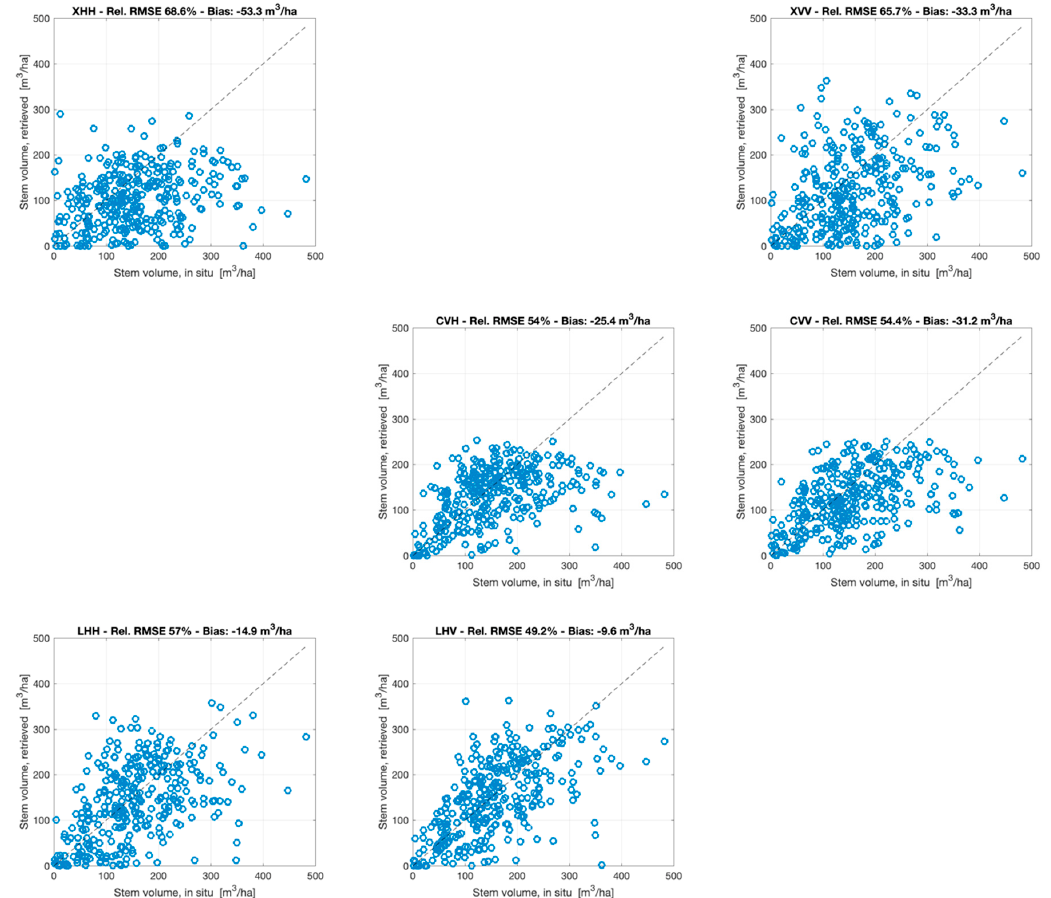
Figure 11. Scatter plots of measured and retrieved stem volume at Krycklan for a multi-temporal combination of estimates obtained at a given frequency band and